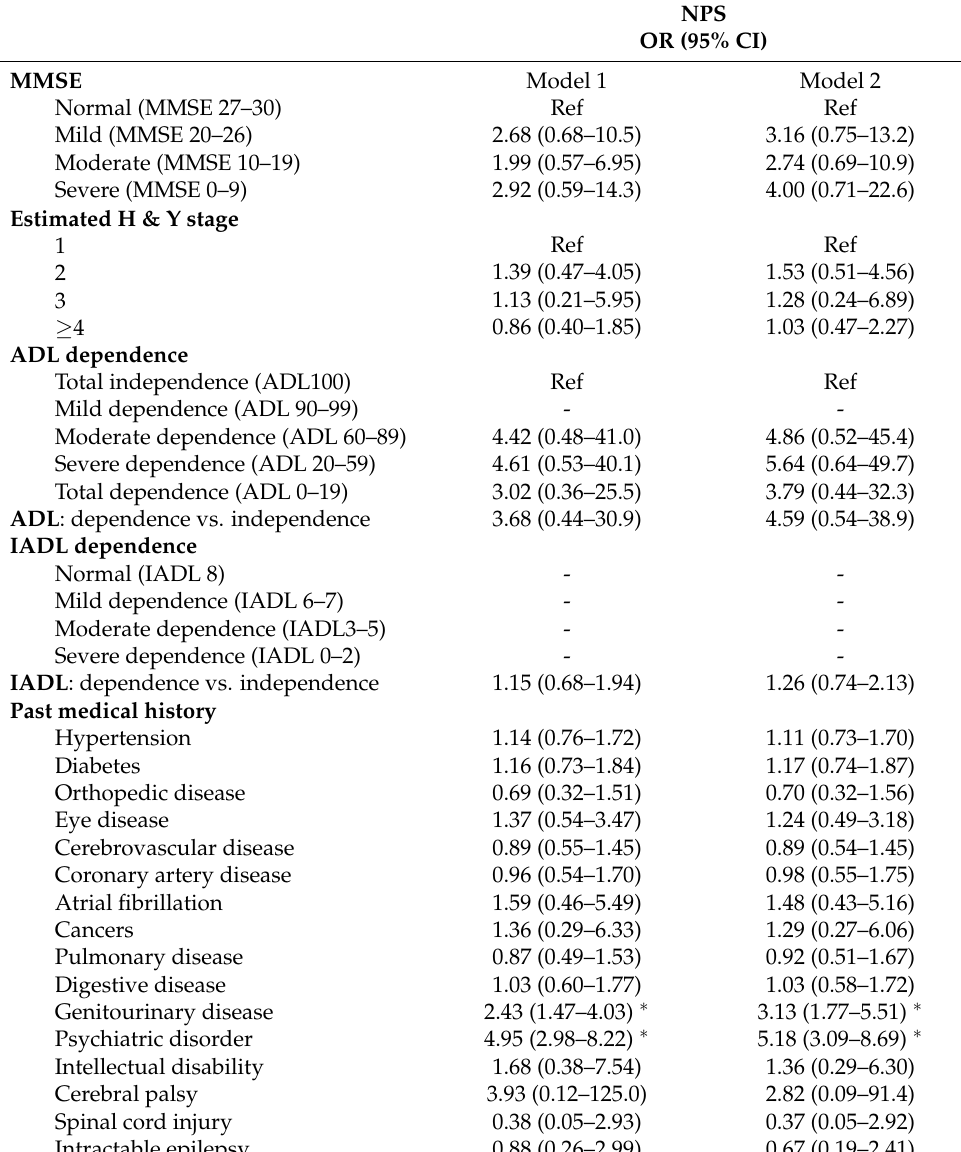
Table 4. Risks of cognition, PD severity, and past medical history for